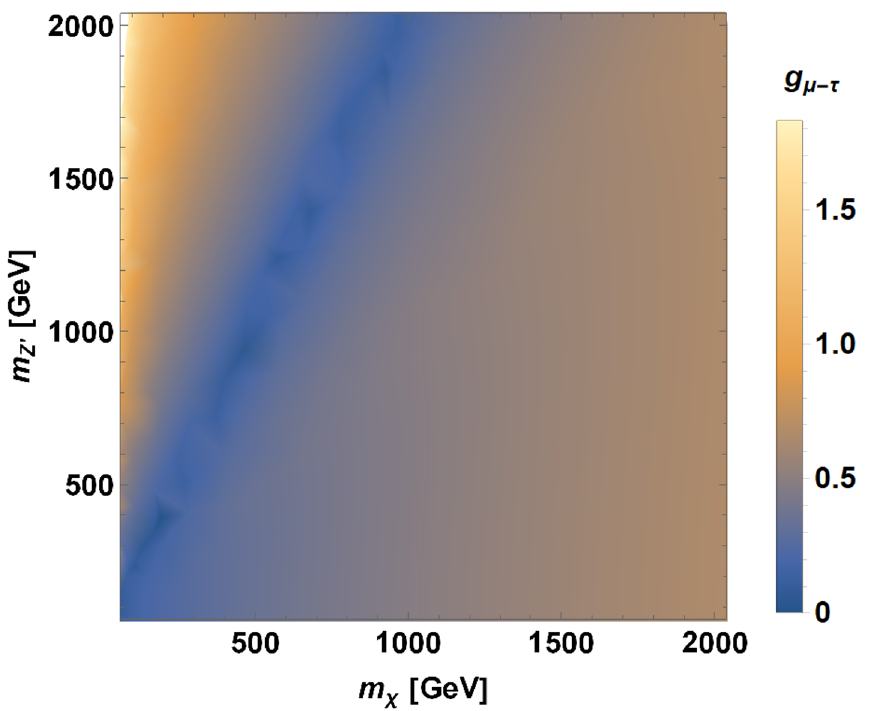
Figure 6 . Masses and gauge coupling required for correct DM abundance in the L µ − L τ